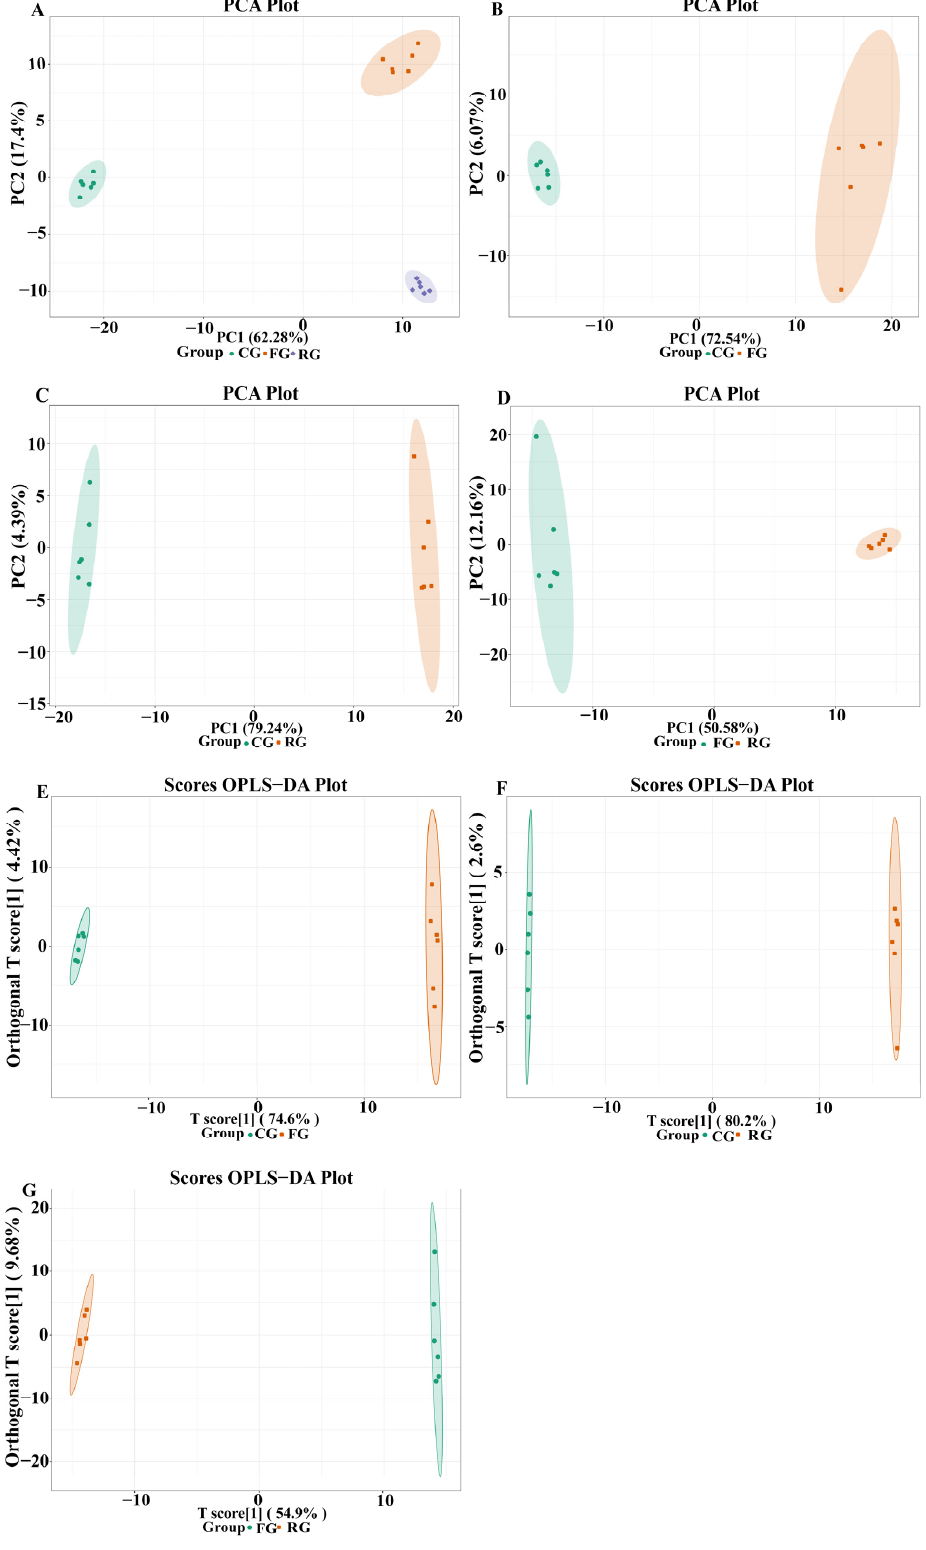
Figure 2. PCA plots showing the different metabolic patterns of dry-cured beef meat. ( A ) All dry- cured beef meat samples, ( B ) meat samples from the CG (control group) and FG (fermented